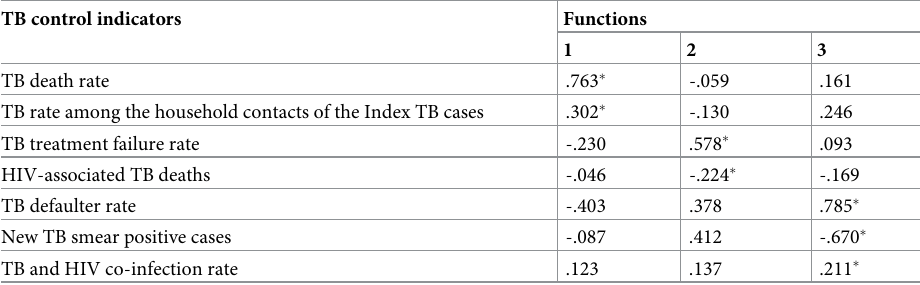
Table 7. Structure matrix following a canonical discrimination analysis.